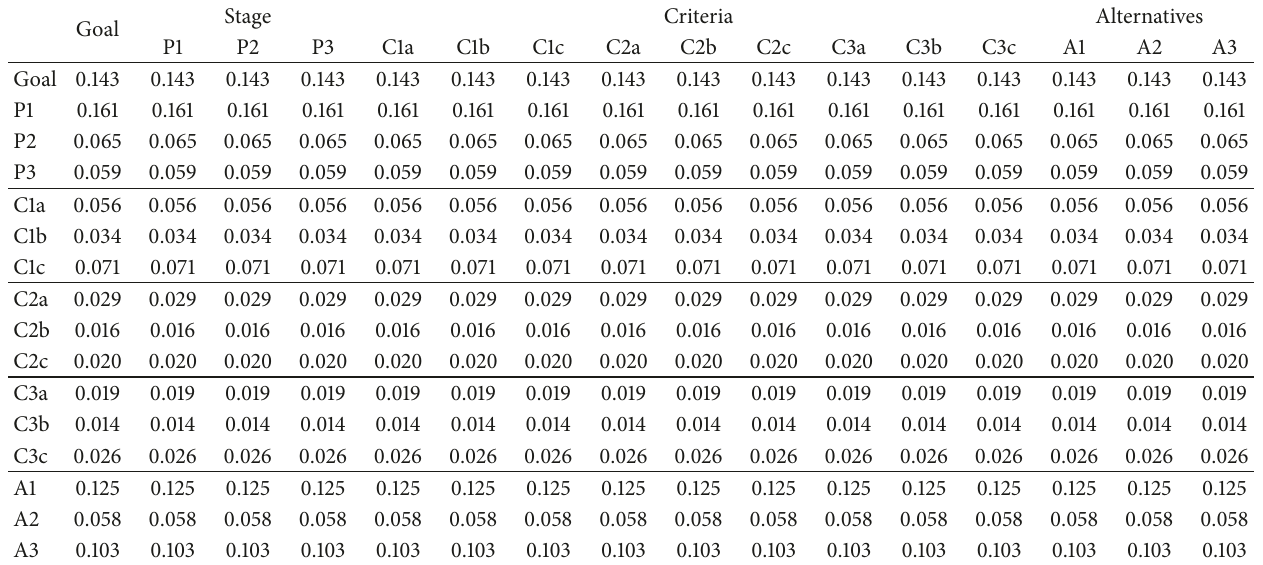
Table 6: Limiting